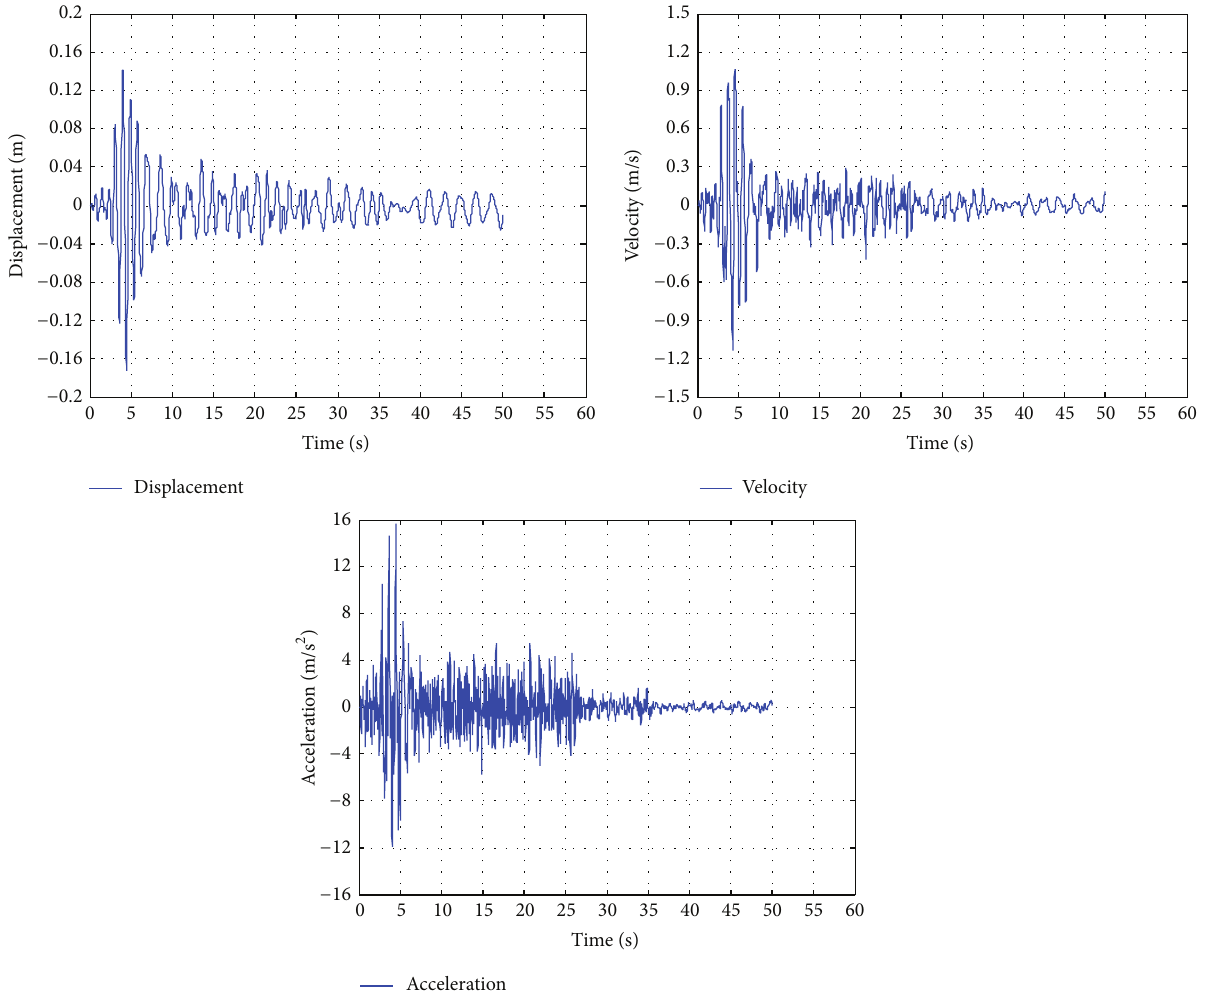
Figure 6: Dynamic responses of the middle foundation ( 𝑉 𝑤 = 400